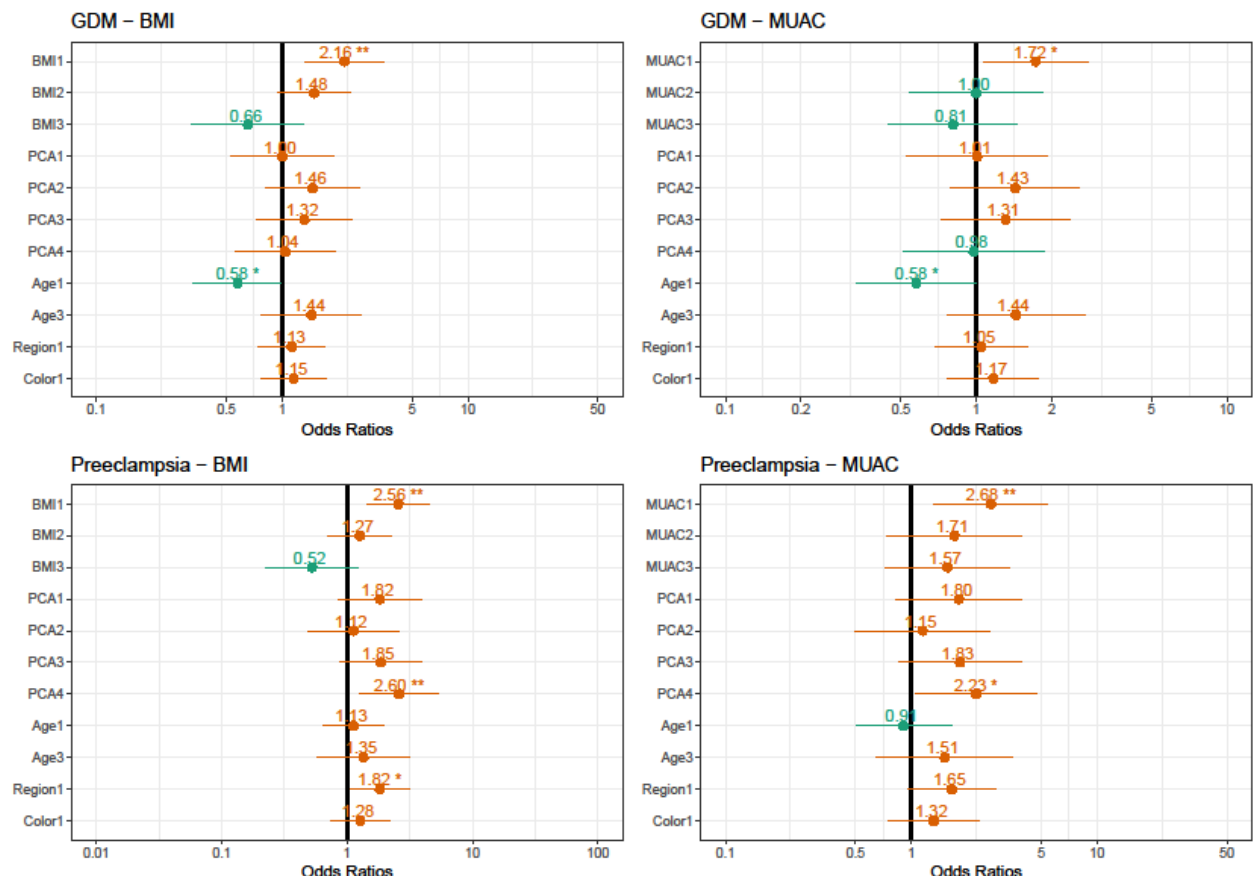
Figure 3. Estimated risks for Gestational diabetes mellitus and preeclampsia using BMI or MUAC. BMI 1: obese; BMI 2: overweight; BMI 4: underweight. MUAC 1: obese; MUAC 2: overweight; MUAC 4: underweight. PCA 1: Obesogenic; PCA 3: Intermediate; PCA 4: Vegetarian; PCA 5: Protein. Age 1: <20, Age 3: >34 years; Region 1: Northeast. Color 1: Non-white. Gestational diabetes mellitus AIC = BMI model: 789.3831/MUAC model: 776.5544. Preeclampsia AIC = BMI model: 589.2154/MUAC model: 574.0860. * Values of OR are significant at p < 0.05. ** Values of OR are significant at p <